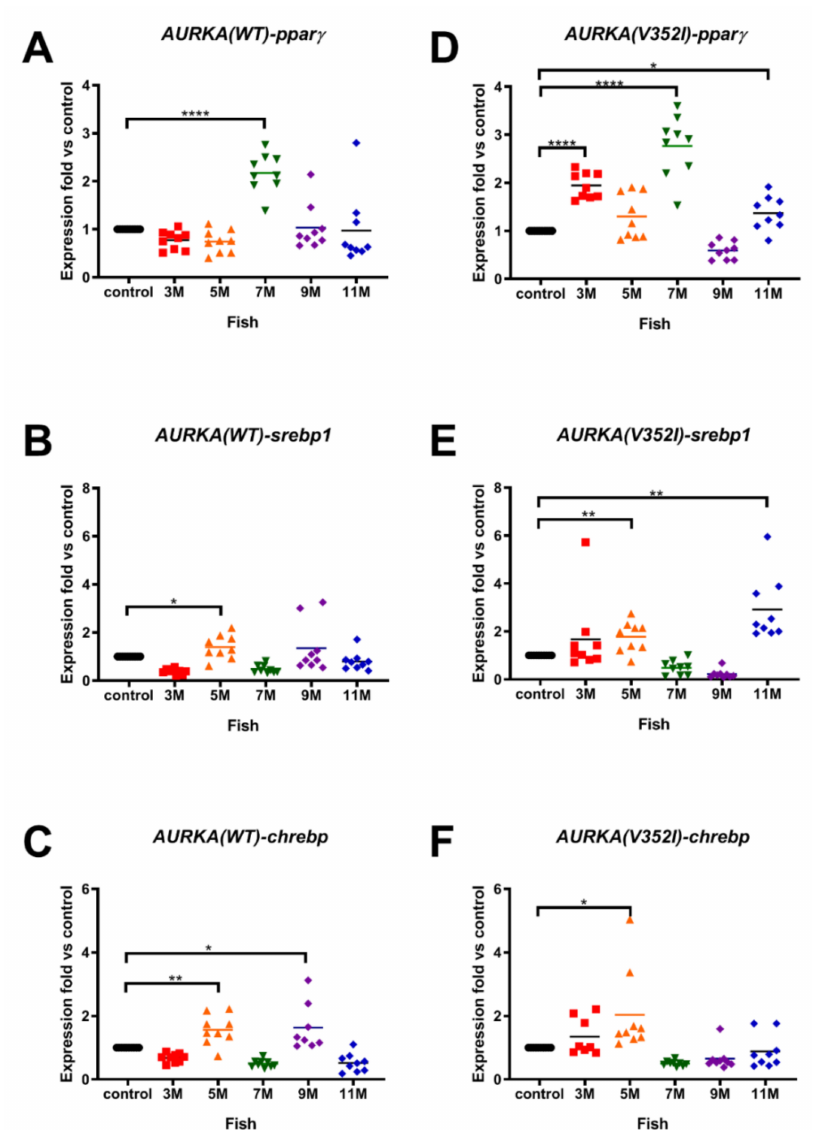
Figure 2. Expression of lipogenic factors (peroxisome proliferator-activated receptor gamma ( ppar γ ), sterol regulatory element-binding transcription factor 1 ( srebp1 ), carbohydrate-responsive element-binding protein ( chrebp )) in AURKA(WT) and AURKA(V352I) transgenic fish were higher than control. qPCR analysis of lipogenic factors ( A , D ) ppar γ ; ( B , E ) srebp1 ; ( C , F ) chrebp in AURKA(WT) ( A – C ) and AURKA(V352I) ( D – F ) transgenic zebrafish compared to control fish at di ff erent time points. Expression fold compared to control fish Tg(fabp10a:EGFP-mCherry is shown in red (3 M), orange (5 M), green (7 M), purple (9 M), and blue (11 M). Statistical analysis of results was performed using a two-tailed Student’s t -test. Asterisks (*) represent the level of significance. * p -value ≤ 0.05; ** p -value ≤ 0.01; *** p -value ≤ 0.001; **** p -value ≤